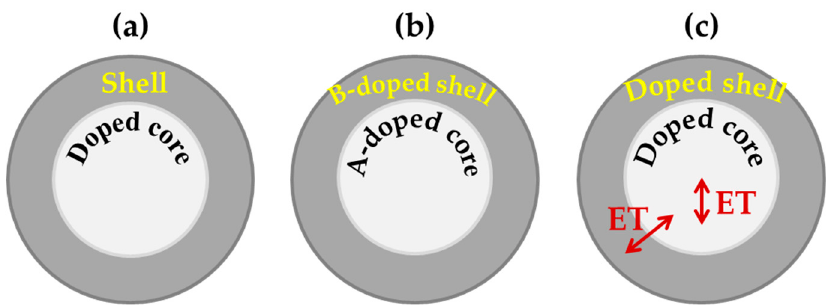
Figure 10. Schematics of the most common core-shell architectures: ( a ) passive-shell design, ( b ) active- shell coating design where A and B refer to different dopants, and ( c ) energy transfer (ET) core-shell ( b ) active-shell coating design where A and B refer to di ff erent dopants, and ( c ) energy transfer design. (ET) core-shell